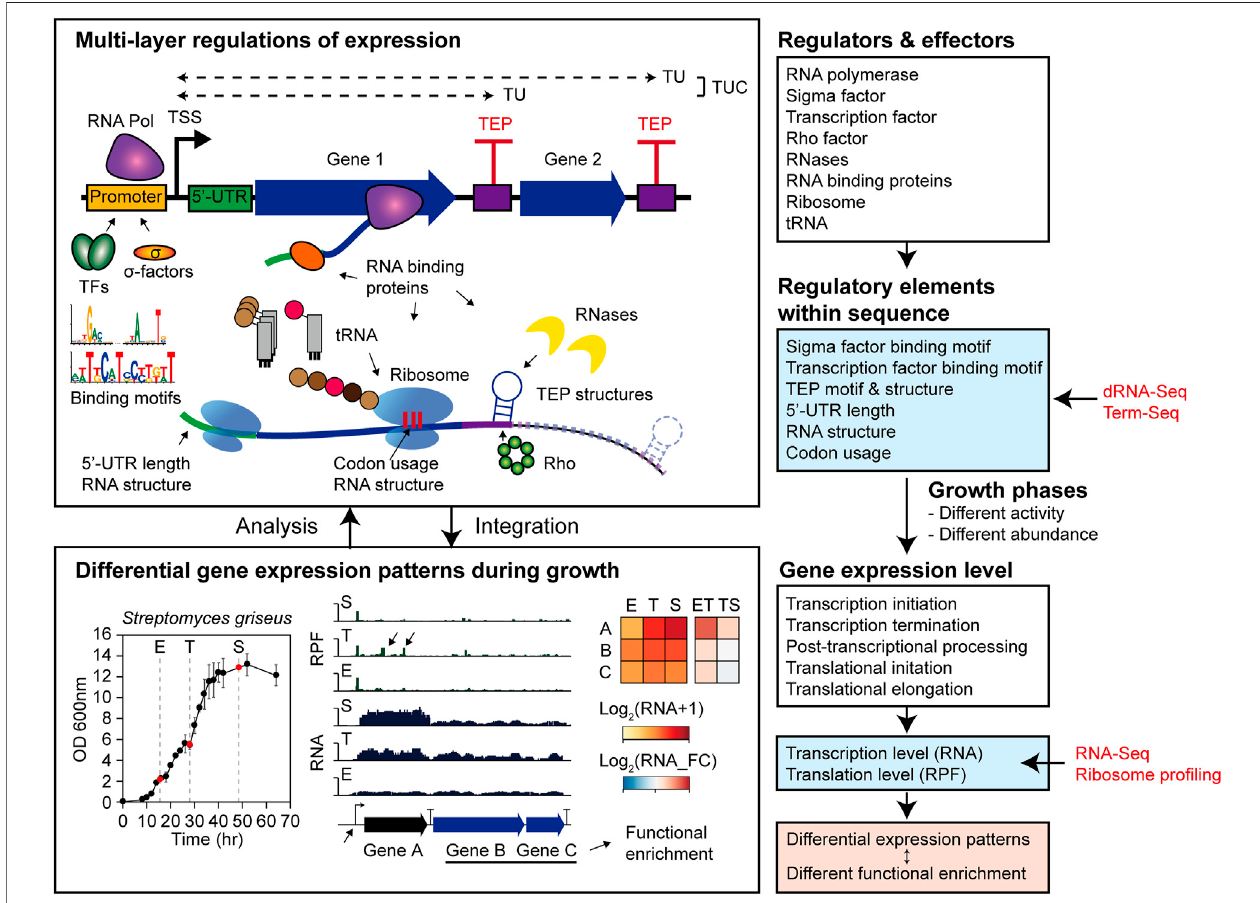
FIGURE 8 | Overall conclusion scheme of this